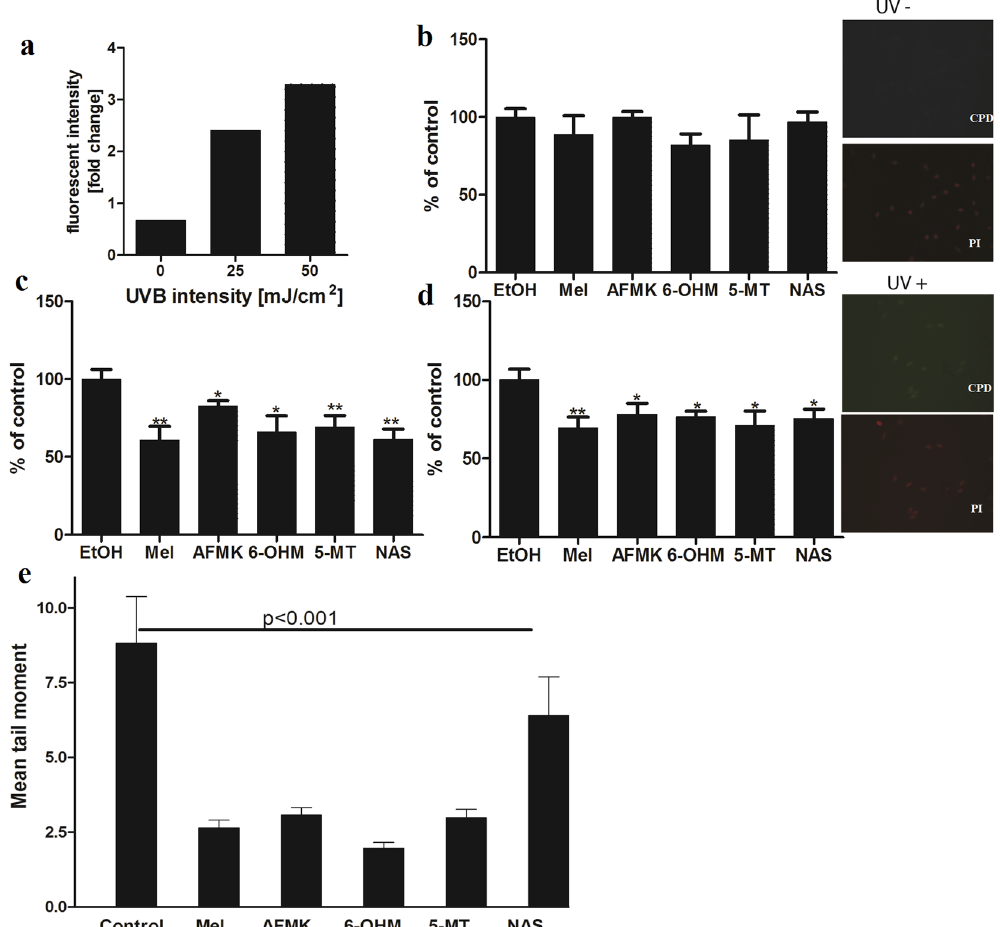
Figure 2. Melatonin, NAS, 6-OHM, AFMK, and 5-MT exhibit repair capacities in UVB-induced DNA damage in treated melanocytes as shown by reduced levels of CPD and comet cell tail moments. Cells were treated with melatonin or its metabolites for 24 h prior UV irradiation at the concentration 5 × 10 − 5 M, further exposed to UVB intensities of 25 or 50 mJ/cm 2 and immediately treated again with melatonin or its derivatives for 3 h. Cells were fixed and stained with anti-CPD antibody and further imaged with a fluorescence microscope. Fluorescence intensity was analysed using ImageJ software and data were analysed using Graph Pad Prizm. CPD formation under different UVB intensity levels are shown in ( a ). Figure presents CPD levels after 0 mJ/ cm 2 ( b ), 25 mJ/cm 2 ( c ) and 50 mJ/cm 2 ( d ). Data are presented as percentile of control and were analyzed using t- test, * p < 0.05, ** p < 0.01. As an example, images of the melanocytes stained with CPD antibody (green) and nuclear staining with propidium iodine (red) show no CPD signal in non-irradiated melanocytes (UV − ) and positive CPD signal in UVB (25 mJ/cm 2 ) irradiated cells (UV + ) (magnification 20x). Also, melanocytes were treated with melatonin or its metabolites before and after UV irradiation (200 mJ/cm 3 ). Tail moment is an index of DNA damage. Data are analysed using student t-test and p < 0.001 for all conditions ( e